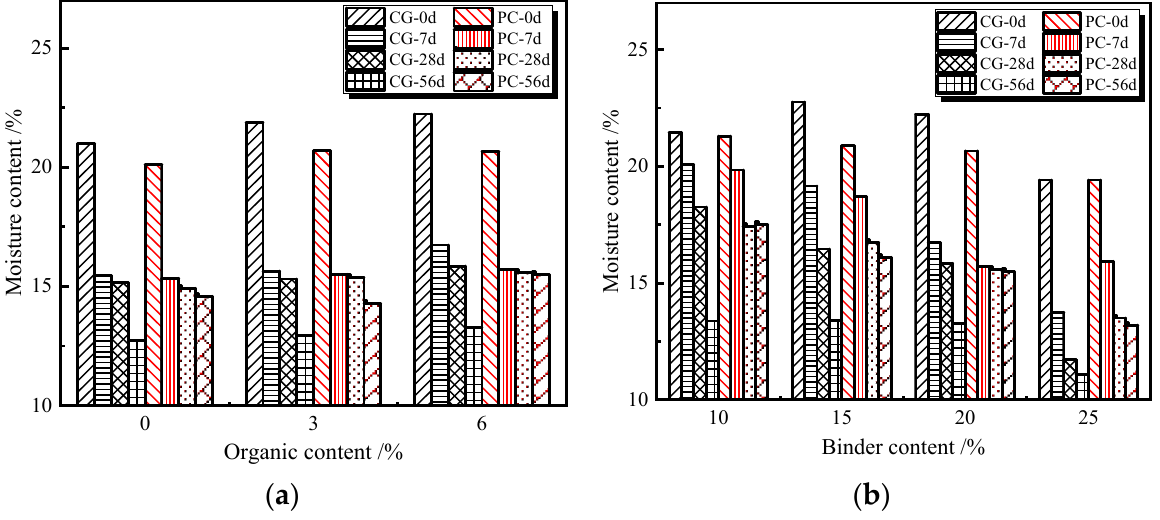
Figure 6. The moisture content of CG/PC-stabilized samples under different conditions. ( a ) Influence of organic content. ( b ) Influence of binder dosage